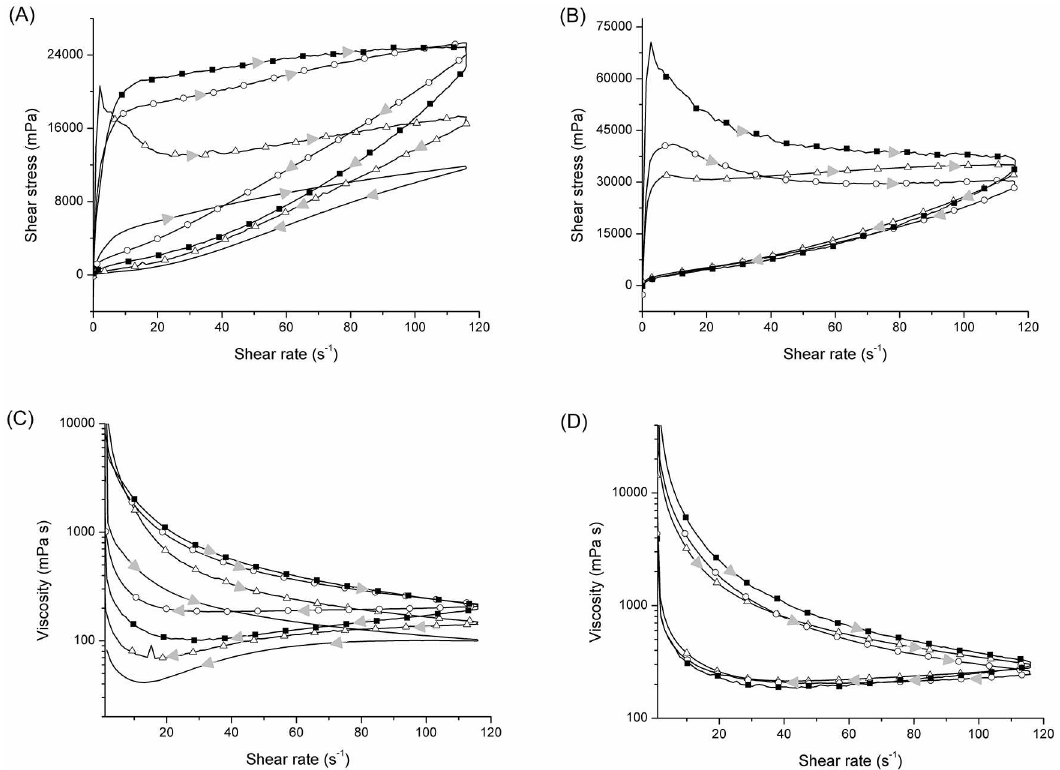
Fig 4. Flow curves of yogurt samples without heat treatment (A) with heat treatment (B); viscosity curves of yogurt samples without heat treatment (C) and with heat treatment (D). Yogurt without curdlan(–), with commercial curdlan ( Δ ), with pre-gelledcommercial curdlan ( (cid:14) ) and with curdlan produced by Agrobacterium sp. IFO 13140 (pre-gelation method) ( ■ ). The directionof the gray arrows indicatesthe ascendantand descendant curves.